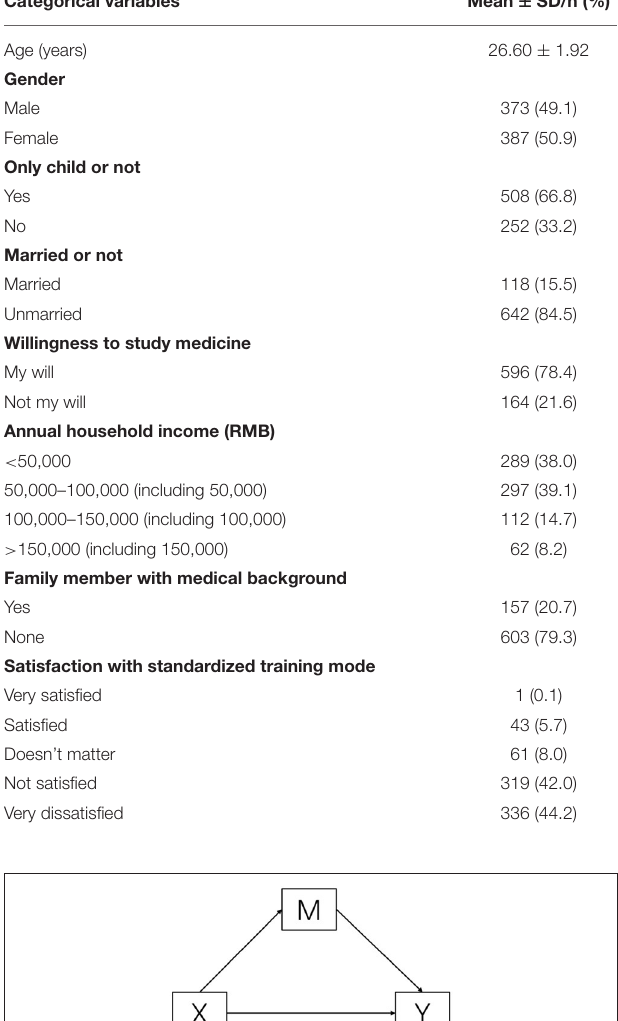
TABLE 2 | Scores and degrees of depression, anxiety, and stress.